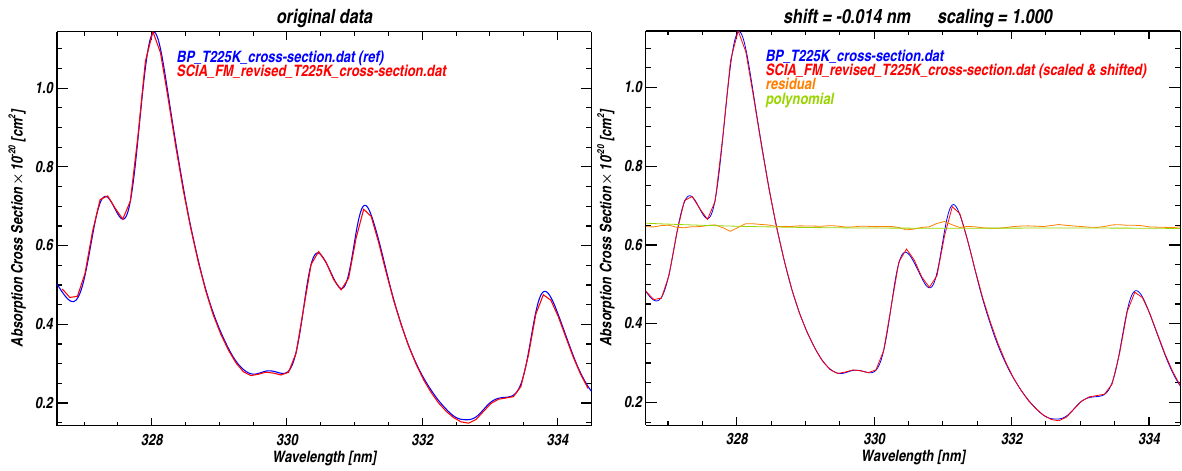
Fig. 11. (Left) Comparison of SCIAMACHY FM revised data with BP data convolved with SCIAMACHY slit function at 225K in the same DOAS fitting window as Fig. 10. (Right) The revised SCIAMACHY FM revised data after proper wavelength shift and scaling together with BP data and the residuals (orange) and the retrieved baseline polynomial (green).